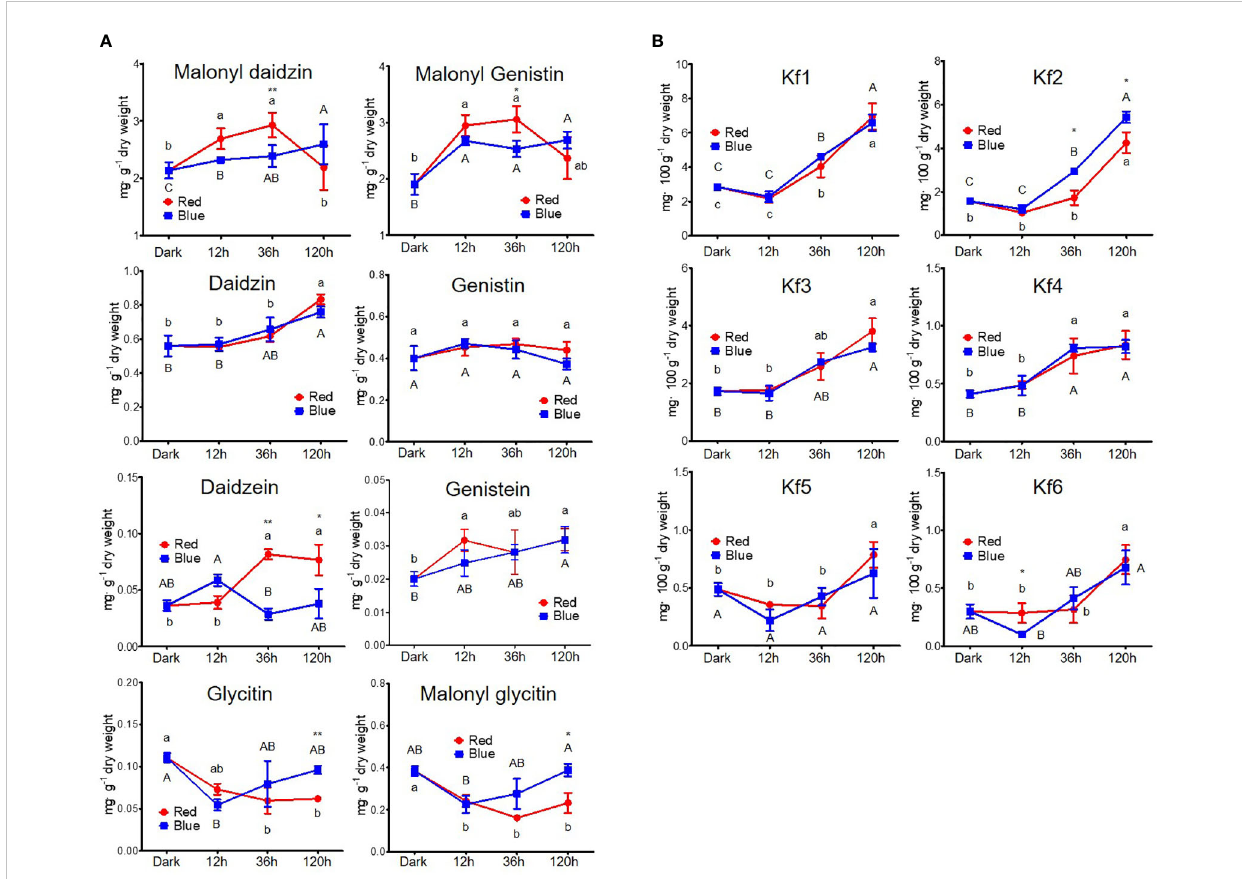
FIGURE 3 Content of fl avonoids, including iso fl avone (A) and kaempferol glycoside (B) . The following abbreviations indicate Kf1, kaempferol-3- O -glycosyl (1 ! 2)-rhamnosyl(1 ! 6)-galactoside; Kf2, kaempferol-3- O -(2,6-dirhamnosyl)-galactoside; Kf3, kaempferol-3- O -digalactoside; Kf4, kaempferol-3- O - diglucoside; Kf5, kaempferol-3- O -rhamnosyl-galactoside; Kf6, kaempferol-3- O -rutinoside; RE, robinin equivalent. Different lower and upper case letters (a – c/A-C) indicate signi fi cant differences at p < 0.05 by Tukey ’ s studentized range (HSD) test between irradiation periods within each red and blue light, respectively. Asterisks indicate statistically signi fi cant differences (* p < 0.05; ** p < 0.01) between red and blue light by Fisher ’ s LSD